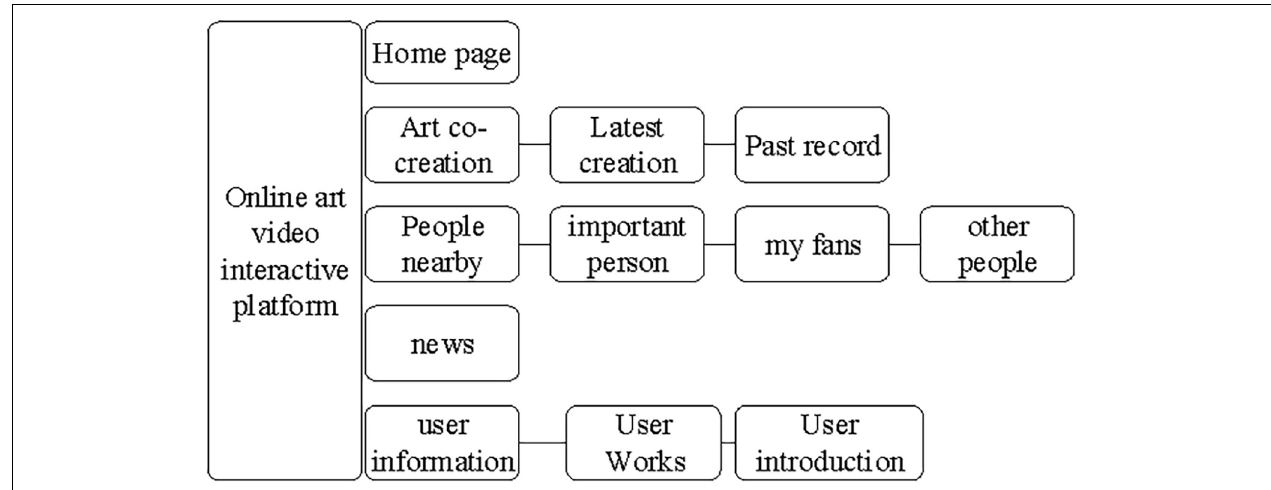
FIGURE 2 | Architecture of the online